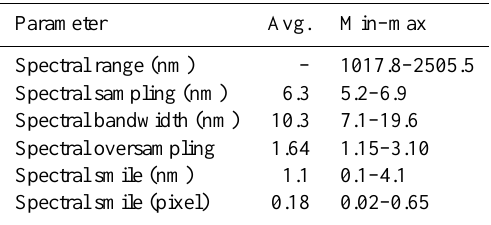
Table 7. Summary of the spectral properties of the specMACS SWIR sensor excluding the first 18